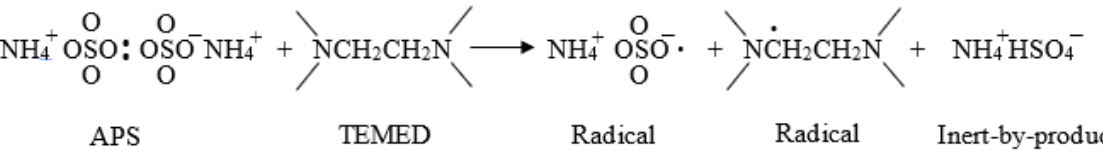
Figure 8. Reaction of APS with TEMED.